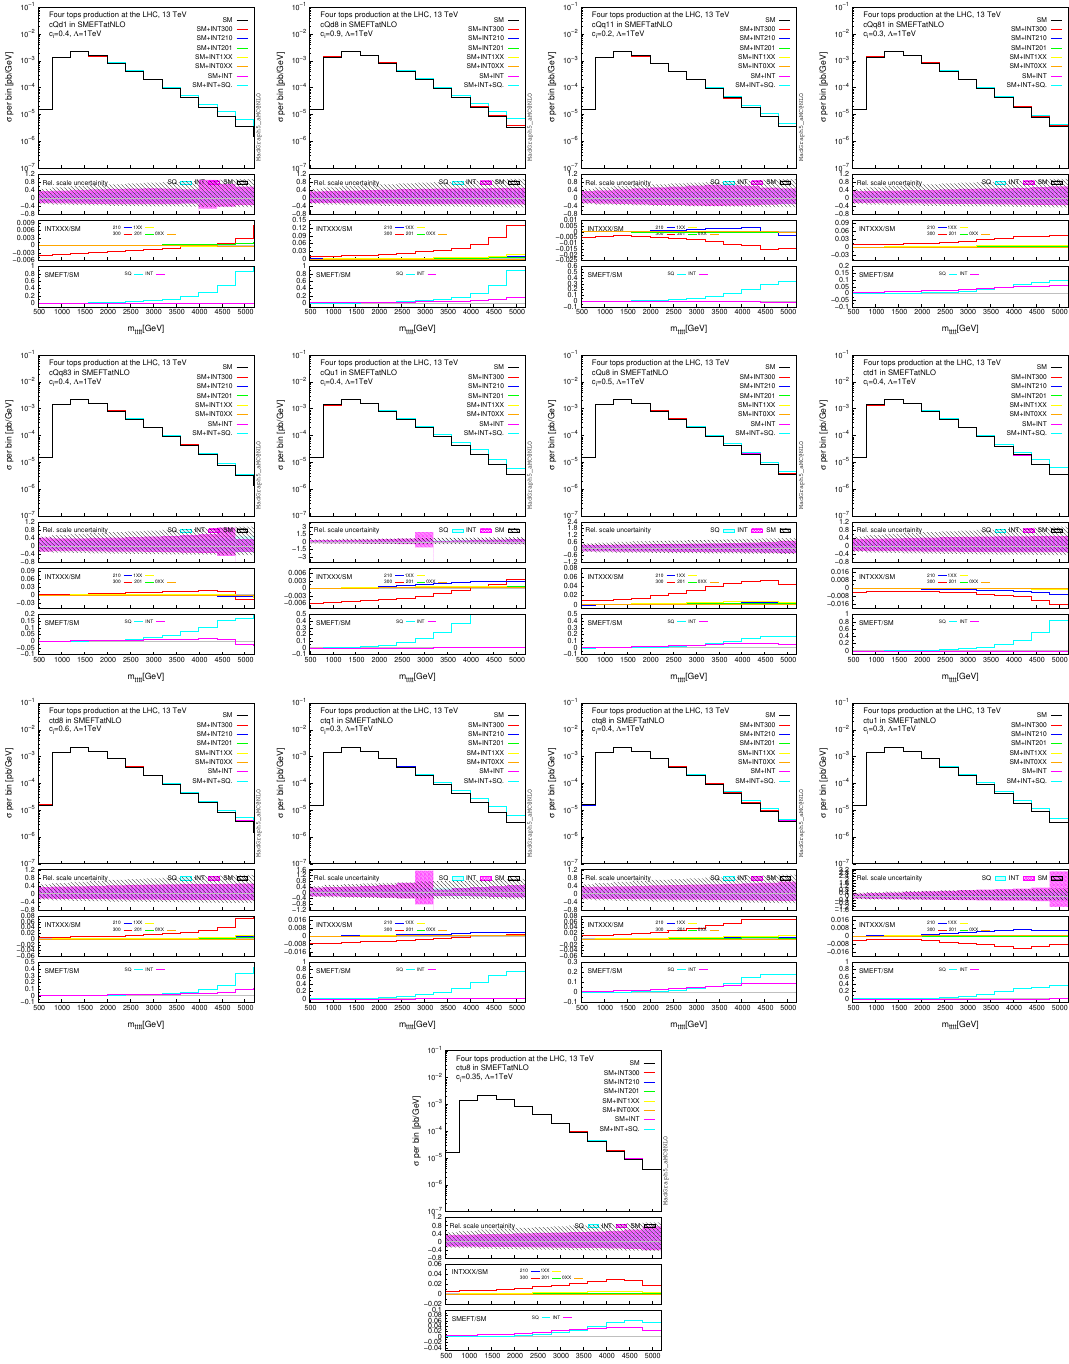
Figure 22 . Same as figure 10 but for the rest of the four-fermion